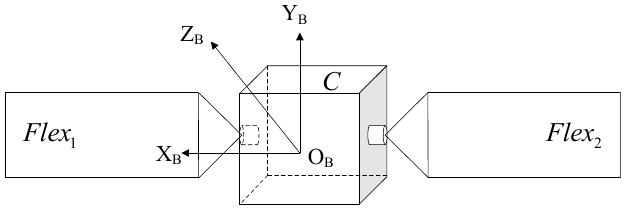
Figure 1. Whole star model and coordinate system.